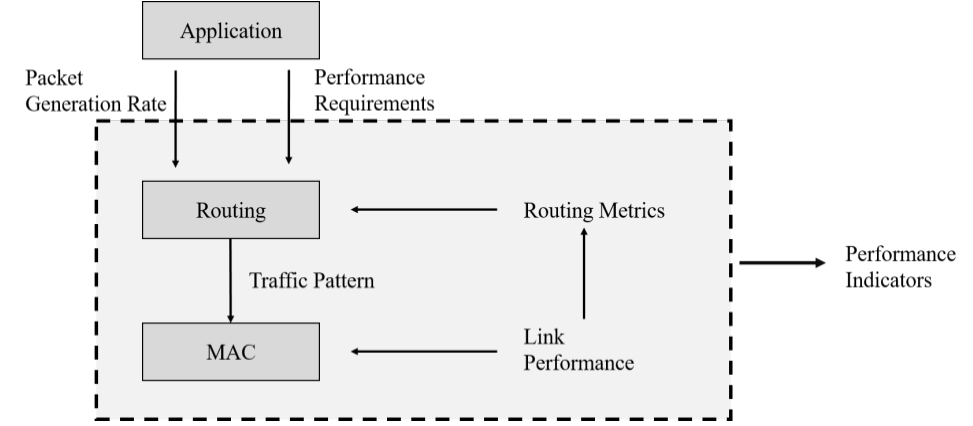
Figure 1. Modeling and design based on MAC and routing layer interaction.